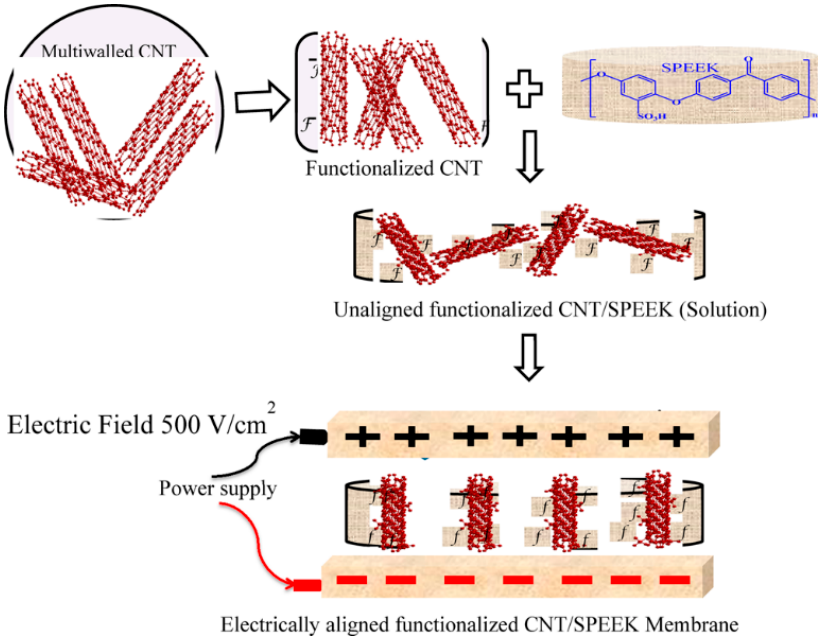
Figure 8. Schematic representation of electrically aligned CNTs in SPEEK matrix. Reproduced from [41], with permission from American Chemical Society, 2015.